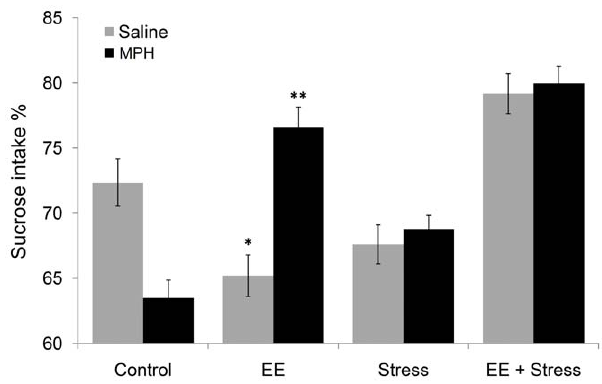
Figure 3. The effect of MPH on sucrose preference test. Considerable variation in sucrose intake was observed between the groups. While significant long term anhedonia was detected in the EE group, MPH treatment following EE significantly recovers this effect. * P , 0.019 versus control; ** P , 0.0001 versus EE saline; n=9 to 10 per group.